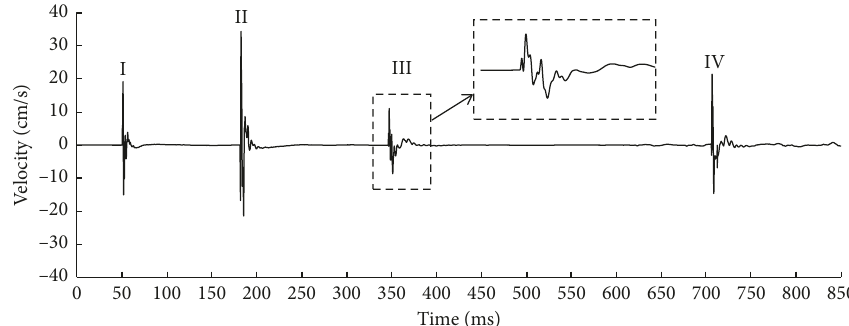
Figure 20: Typical blast vibration waveform in the single-hole blasting experiment (#2). Table 4: Measured PPV s in the single-hole blasting experiment. Sensor no.